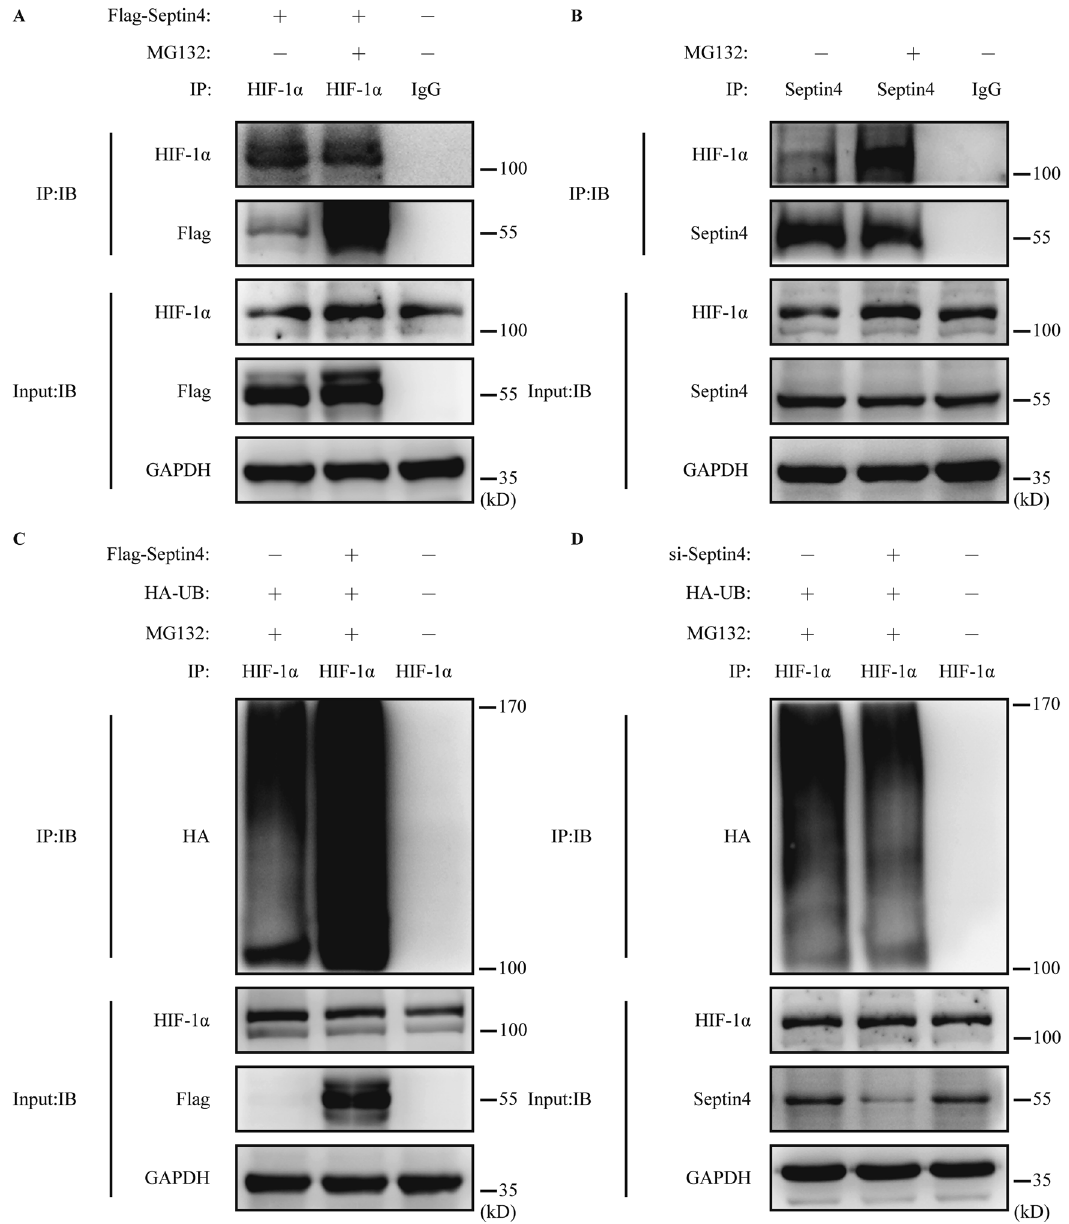
Fig. 5 Septin4 mediates the polyubiquitination of HIF-1 α . A Co-immunoprecipitation analysis of the interaction between exogenous Septin4 and endogenous HIF-1 α under the treatment of MG132 for 8 h. B Co-immunoprecipitation analysis of the interaction between endogenous Septin4 and endogenous HIF-1 α under the treatment of MG132 for 8 h. C Co-immunoprecipitation analysis of the role of Septin4 in regulating the ubiquitination levels of HIF-1 α in H9c2 cells transfected with vector empty or Flag-Septin4. D Co-immunoprecipitation analysis of the role of Septin4 in regulating the ubiquitination levels of HIF-1 α in H9c2 cells transfected with si-Con or